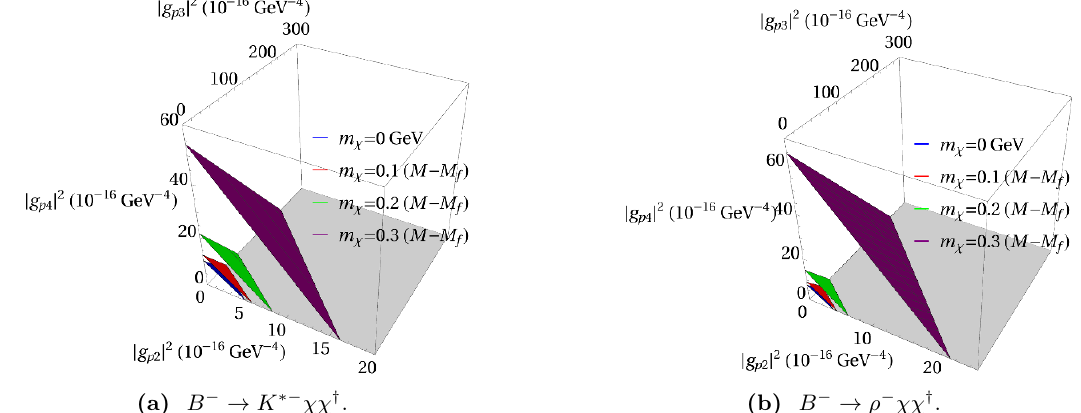
Figure 6. The allowed region of